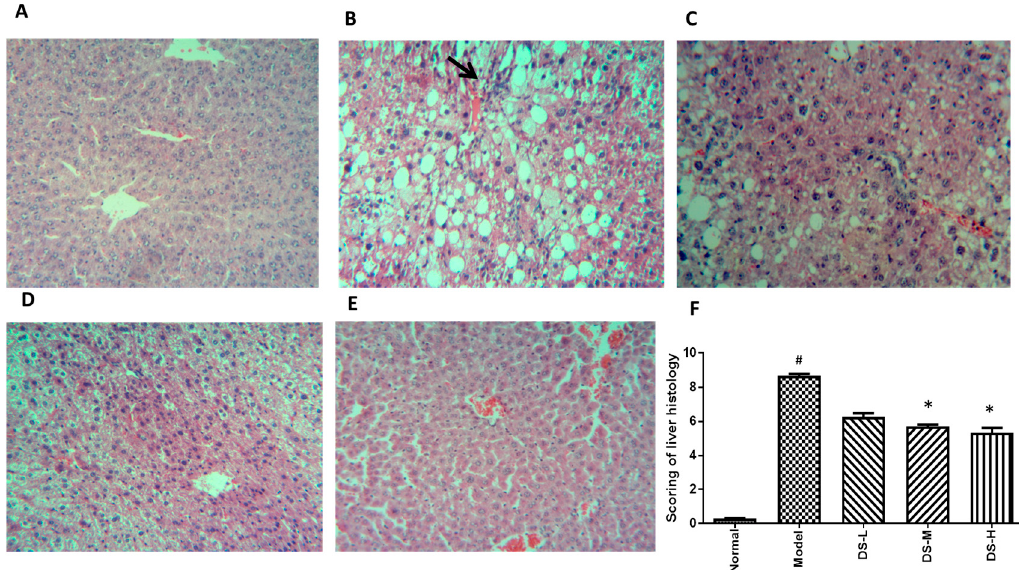
Figure 4. H&E staining results after Danshen treatment in chronic ALD (original magnification 100 × ). Treatment with Danshen for six weeks attenuated the inflammation and macrovacuolar degeneration in chronic ALD mice mode. ( A ) The normal group had a clear structure of the hepatic lobule, and there were no visible lesions; ( B ) In the model group, typical pathological characteristics such as inflammatory infiltration (black arrow) and microvacuolar degeneration can be observed; ( C – E ) Treatment with Danshen (0.093, 0.28, 0.84 g/kg) significantly attenuated the inflammation and vacuolar degeneration in the liver; ( F ) Scoring of liver histology of chronic ALD mice with Danshen treatment (Mean ± SD). DS-L for low dose of Danshen treatment group (0.093 g/kg); DS-M for middle dose of Danshen treatment group (0.28 g/kg); DS-H for high dose of Danshen treatment group (0.84 g/kg). # p < 0.05, compared with normal group * p < 0.05 when compared with model group.